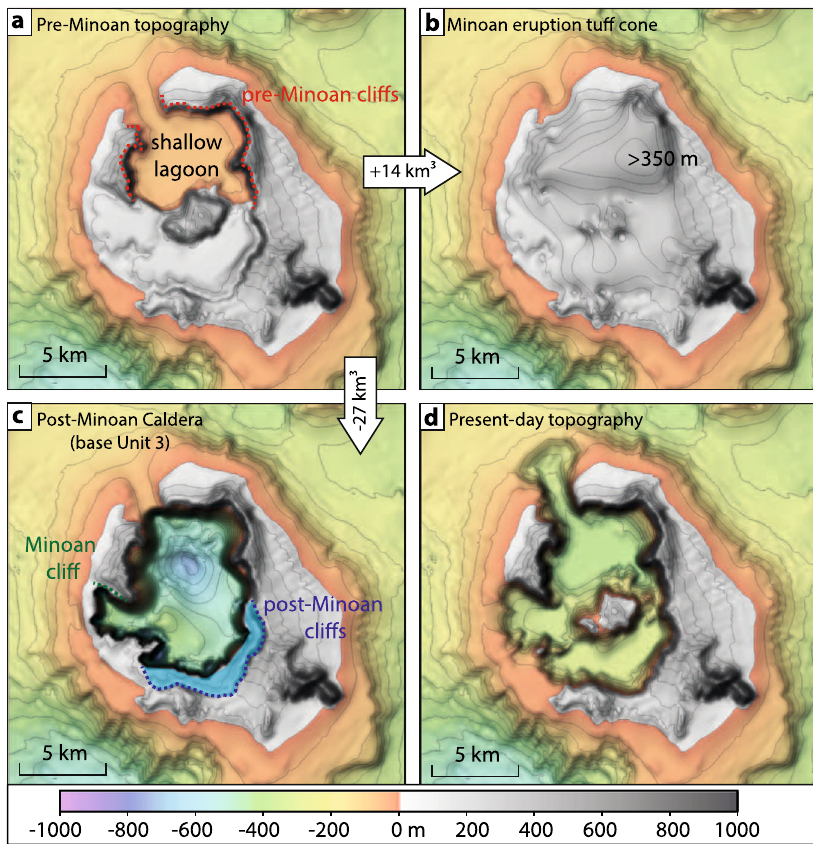
Fig. 4 | Interpreted topographic evolution of the Santorini caldera during the Minoaneruption.a Pre-Minoantopographywithshallowmarinenortherncaldera basin ( “ shallow lagoon ” ) and pre-Minoan cliffs (dotted red lines) 8,28 . b Tuff cone formed during the third phase of the Minoan eruption 4,7 . c Post-Minoan caldera